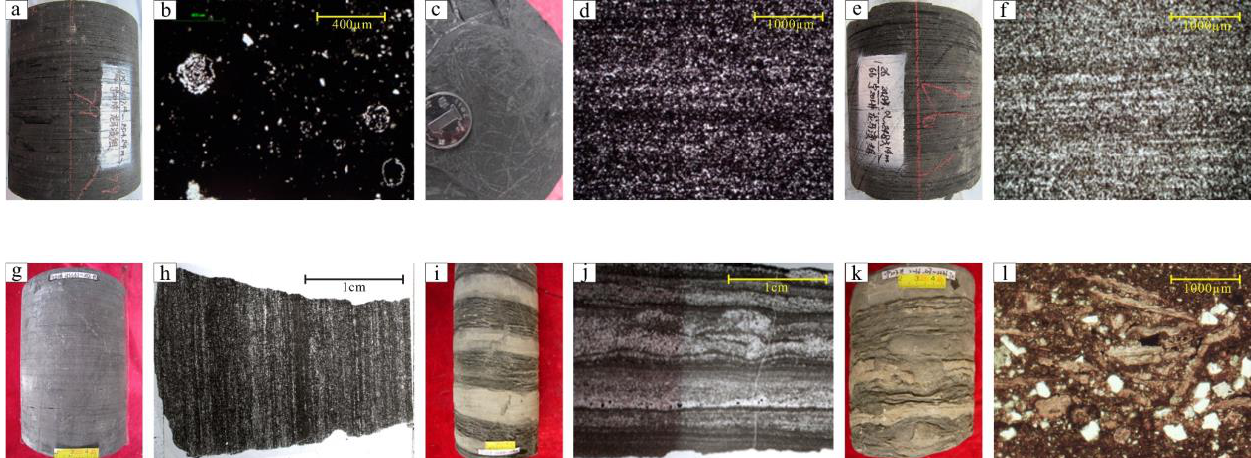
Figure 3. Macroscopic and microscopic features of shale of S 1 l 1 from well N3 in the Changning shale gas field. ( a ). mudstone with local pyrite bands, 2514.24m, N1; ( b ). Siliceous radiolarian development, 2505.77m, N1; ( c ). Black shale with developed graptolite fossils, 3160.18m, N9; ( d ). Horizontal lamina development, siliceous development, 2547.0m, N1; ( e ). Shale horizontal bedding development, 2483.14m, N1; ( f ). Silty shale with developed laminae, 3132.84m, N9; ( g ). Black shale with horizontal bedding development, 2153.67m, N10; ( h ). Silty shale with rhythmic bedding development, 2330.25m, N3; ( i ). Thin layered grayish black calcareous silty mudstone and dark gray calcareous argillaceous siltstone are interbedded with different thicknesses, with rhythmic bedding, 2214.10m, N3; ( j ). Biological peristalsis, 2232m, N3; ( k ). Grayish black silty mudstone mixed with grayish white calcareous siltstone, forming an eyeball-like structure, abrupt change in contact surface, and biological disturbance structure, 2236.47m, N3; ( l ). Clastic accumulation of brachial fauna, 2235.11m, N3.